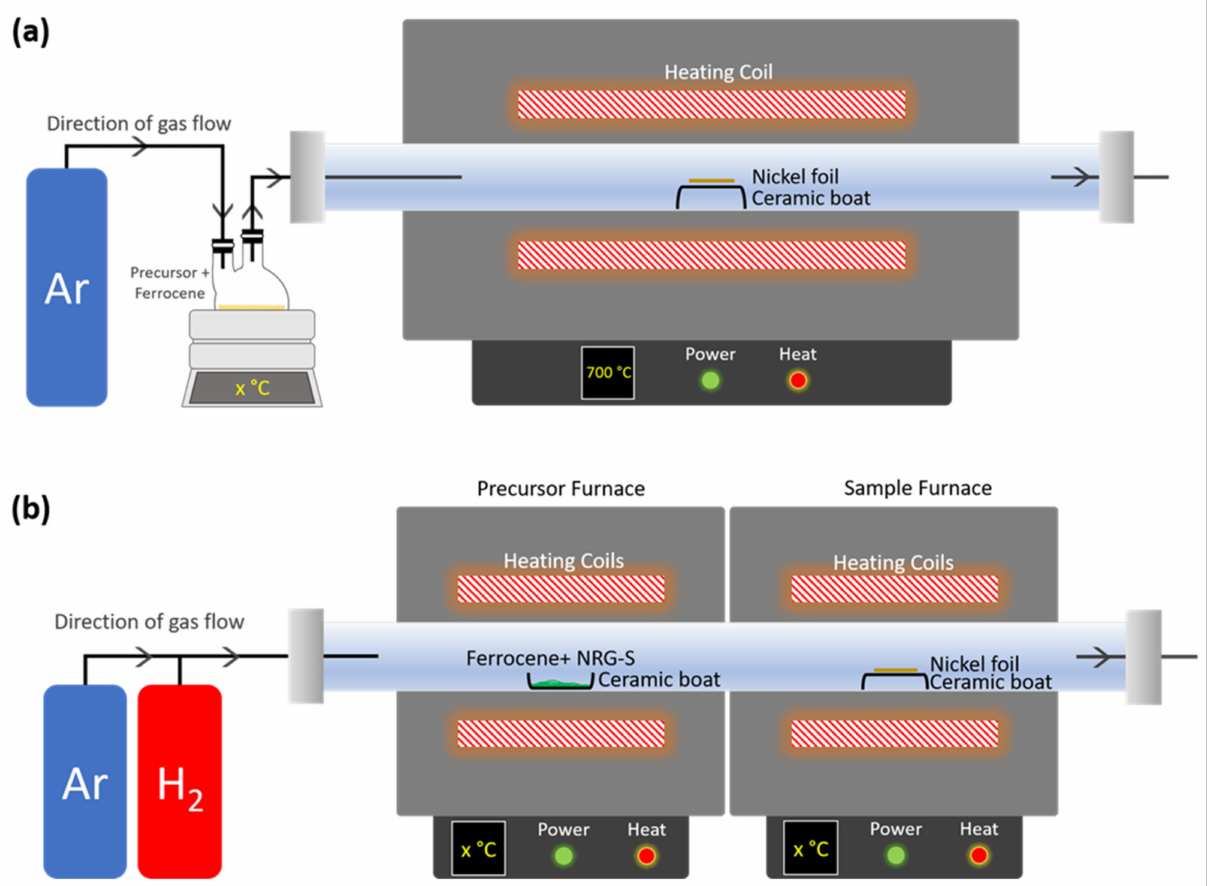
Figure 2. Chemical vapor deposition setup for CNTs synthesis process. ( a ) Single furnace CVD for phase 1 and ( b ) double furnace CVD for phase